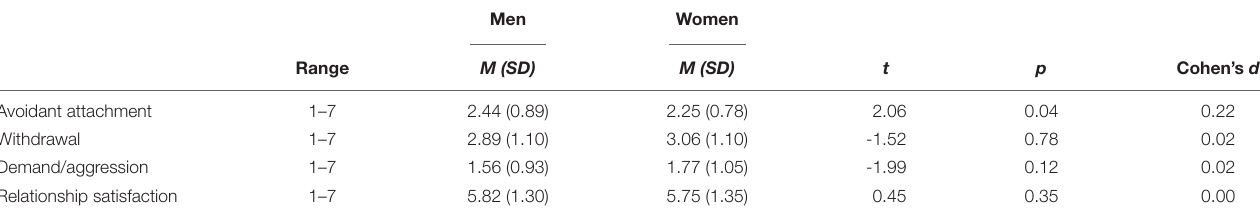
TABLE 2 | Descriptive data and gender differences for the target variables.